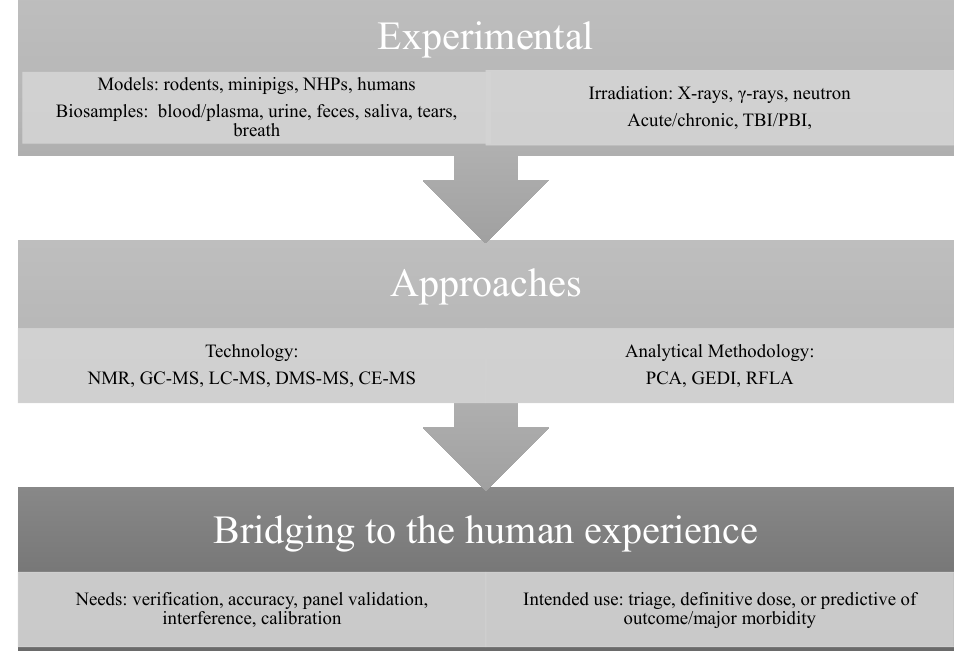
Figure 1. An overview of the radiation metabolomics biodosimetry pathway. Abbreviations: TBI-total body irradiation, PBI-partialbody irradiation, NMR-nuclear magnetic resonance; LC / MS, liquid chromatography / mass spectrometry; GC / MS, gas chromatography / mass spectrometry, DMS-di ff erential ion mobility spectrometry, CE-capillary electrophoresis, PCA-principal component analysis, RFML-random forest machine learning algorithm, GEDI-gene expression dynamics